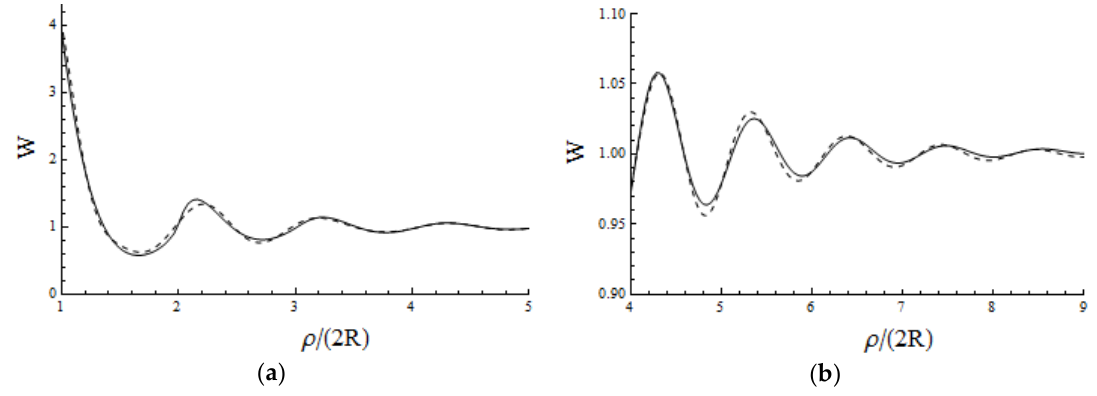
Figure 4. Radial distribution function for filling η = 0.62 ( a ) in the range ρ ∈ { 1,5 } , and ( b ) in the range ρ ∈ { 4,9 } (“a tail of the distribution function”). Solid line is a solution of the Percus–Yevick equation; dashed line corresponds to the smeared lattice model.